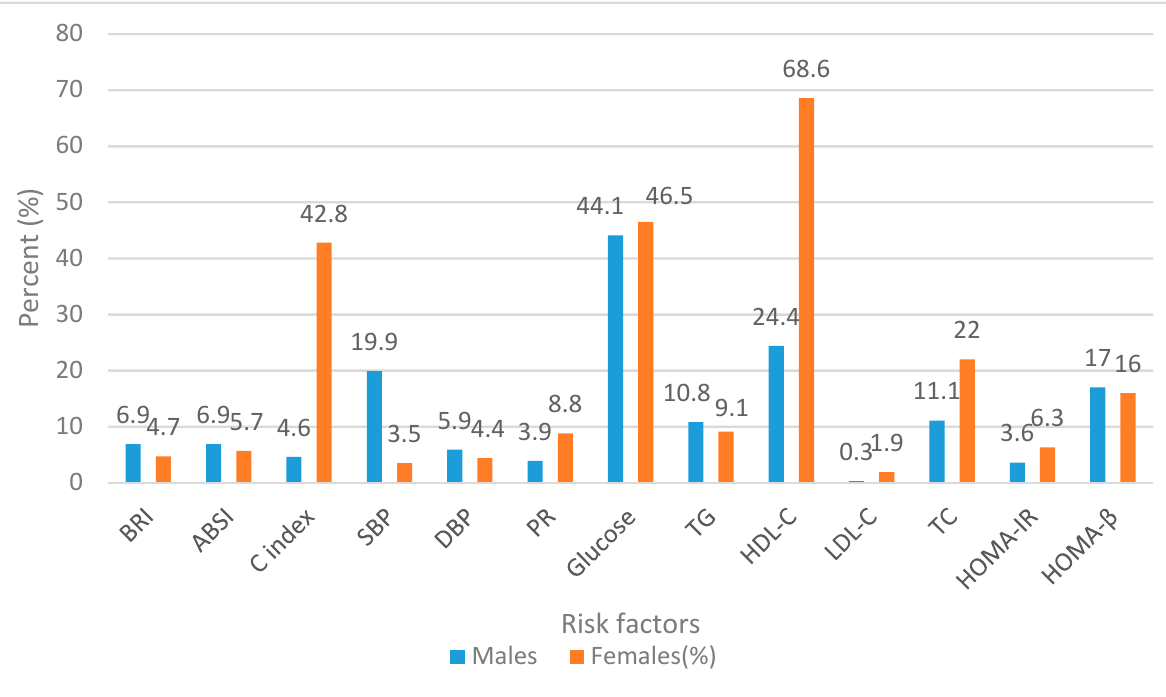
Figure 1. Shows the prevalence of cardiovascular disease (CVD) risk factors using the Body Roundness Index (BRI), A Body Shape Index (ABSI), Conicity Index, blood pressure (BP), and blood samples of Ellisras rural young adults aged 21–30 years